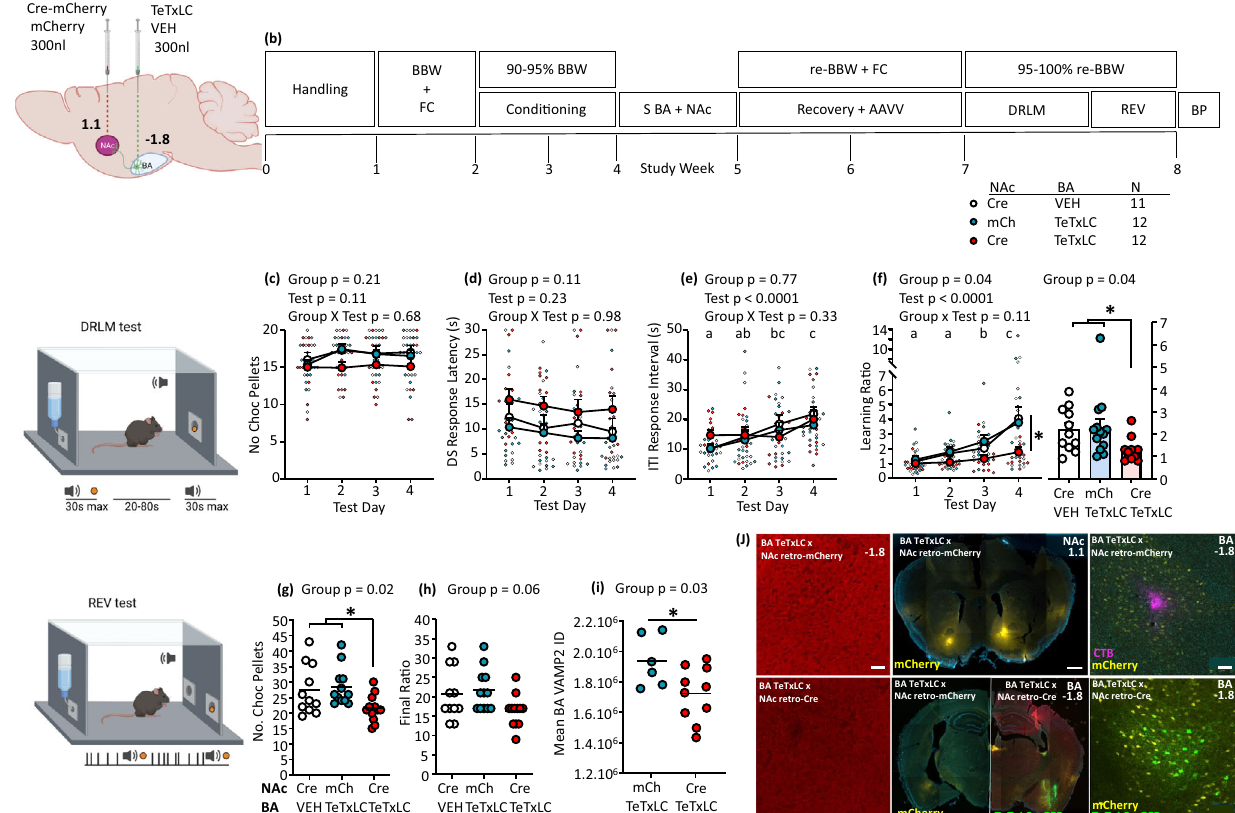
Fig. 4 Effects of tetanus-toxin-light-chain inhibition of BA-NAc neurons on reward-directed behaviour. a Schematic showing bilateral injection site of Cre-dependent TeTxLC AAV vector or vehicle in the BA and of retrograde-Cre AAV vector or retrograde-mCherry AAV vector in the NAc (relative to bregma). b Experimental design. BBW + FC: measurement of baseline body weight and food consumption; 90 – 95% BBW: conditioning under